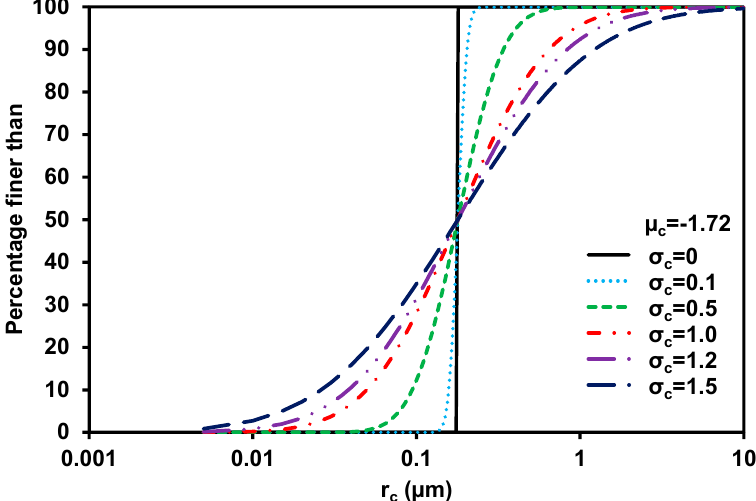
Figure 5. ( a ) Simulated breakthrough curves of contaminant and ( b ) the retention profiles of particles at µ c = − 1.72 and σ c = 0, 0.1, 0.2, 1.0, 1.2, and 1.5.